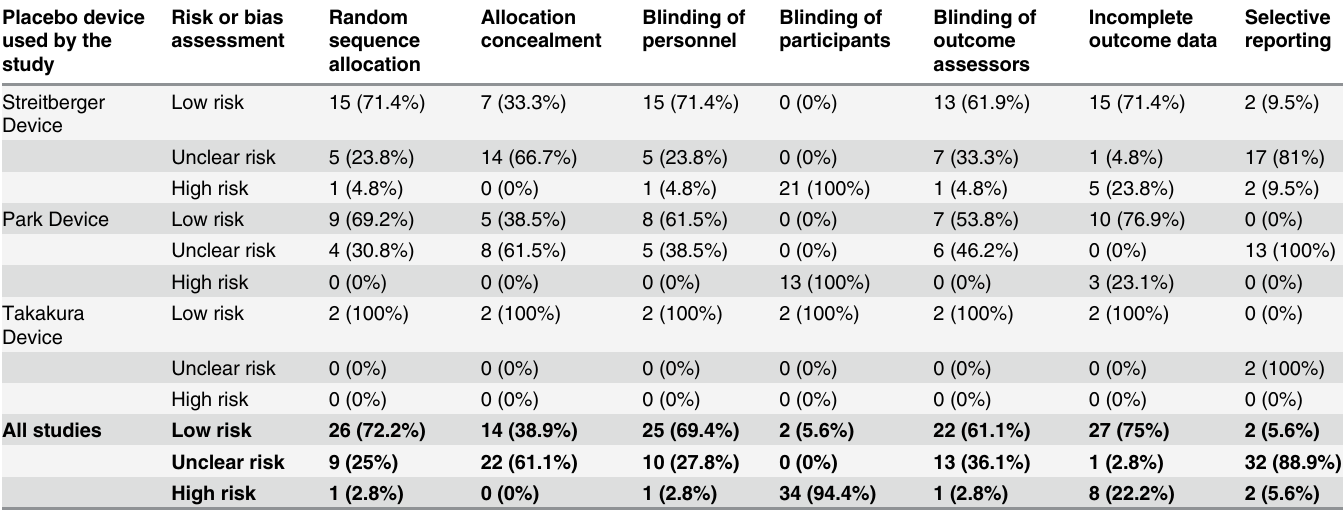
Table 2. Risk of bias assessment of included